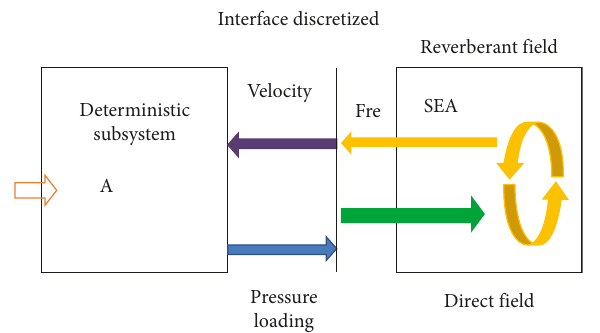
Figure 12: Direct-hybrid transfer